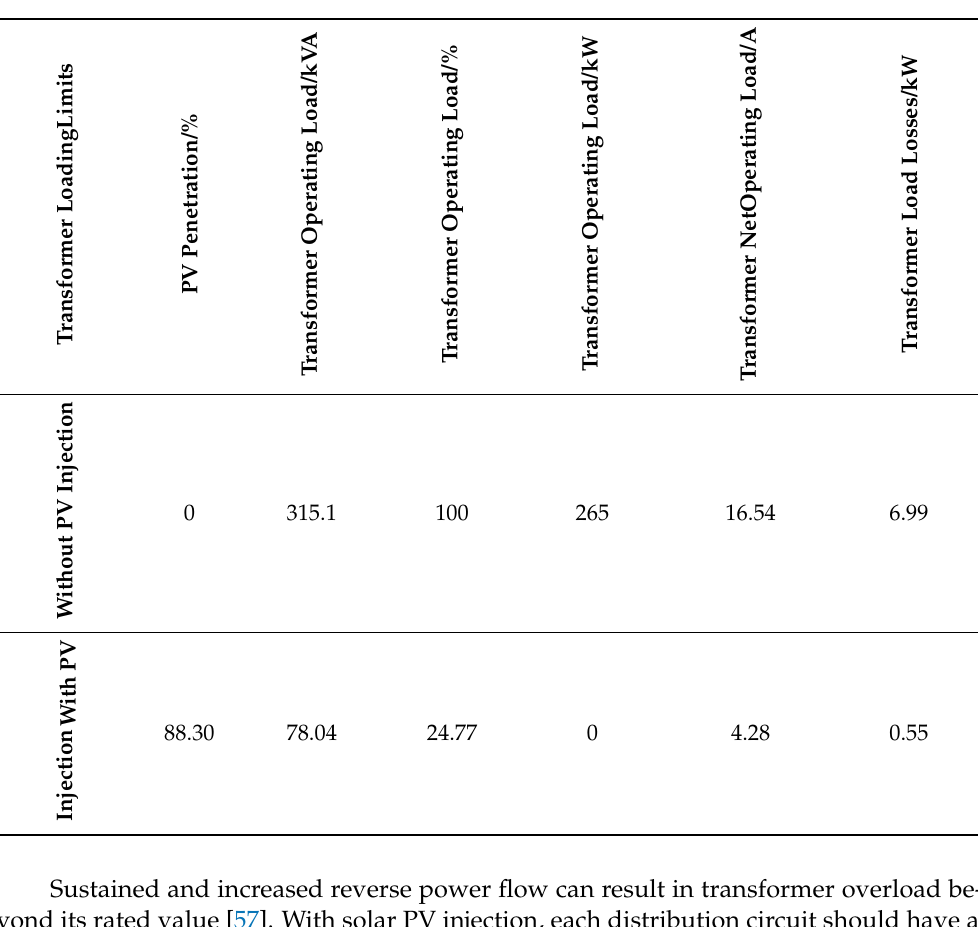
Table 7. Summary of transformer overload and backflow